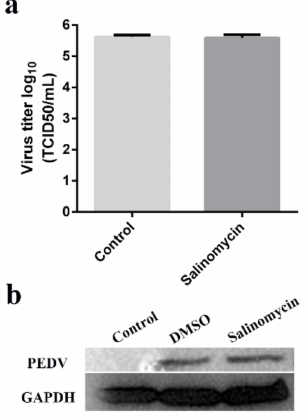
Figure 3. Viricidal effects of salinomycin on PEDV. Viral stocks exposed to salinomycin at 1 µ M at 37 ◦ C for 1 h. Subsequently, the viral yields were titrated by the TCID 50 assays in Vero cells ( a ). The virus propagation in Vero cells after infection for 12 h was checked by western blot ( b ). The assay was performed in duplicate and data presented as the means ±